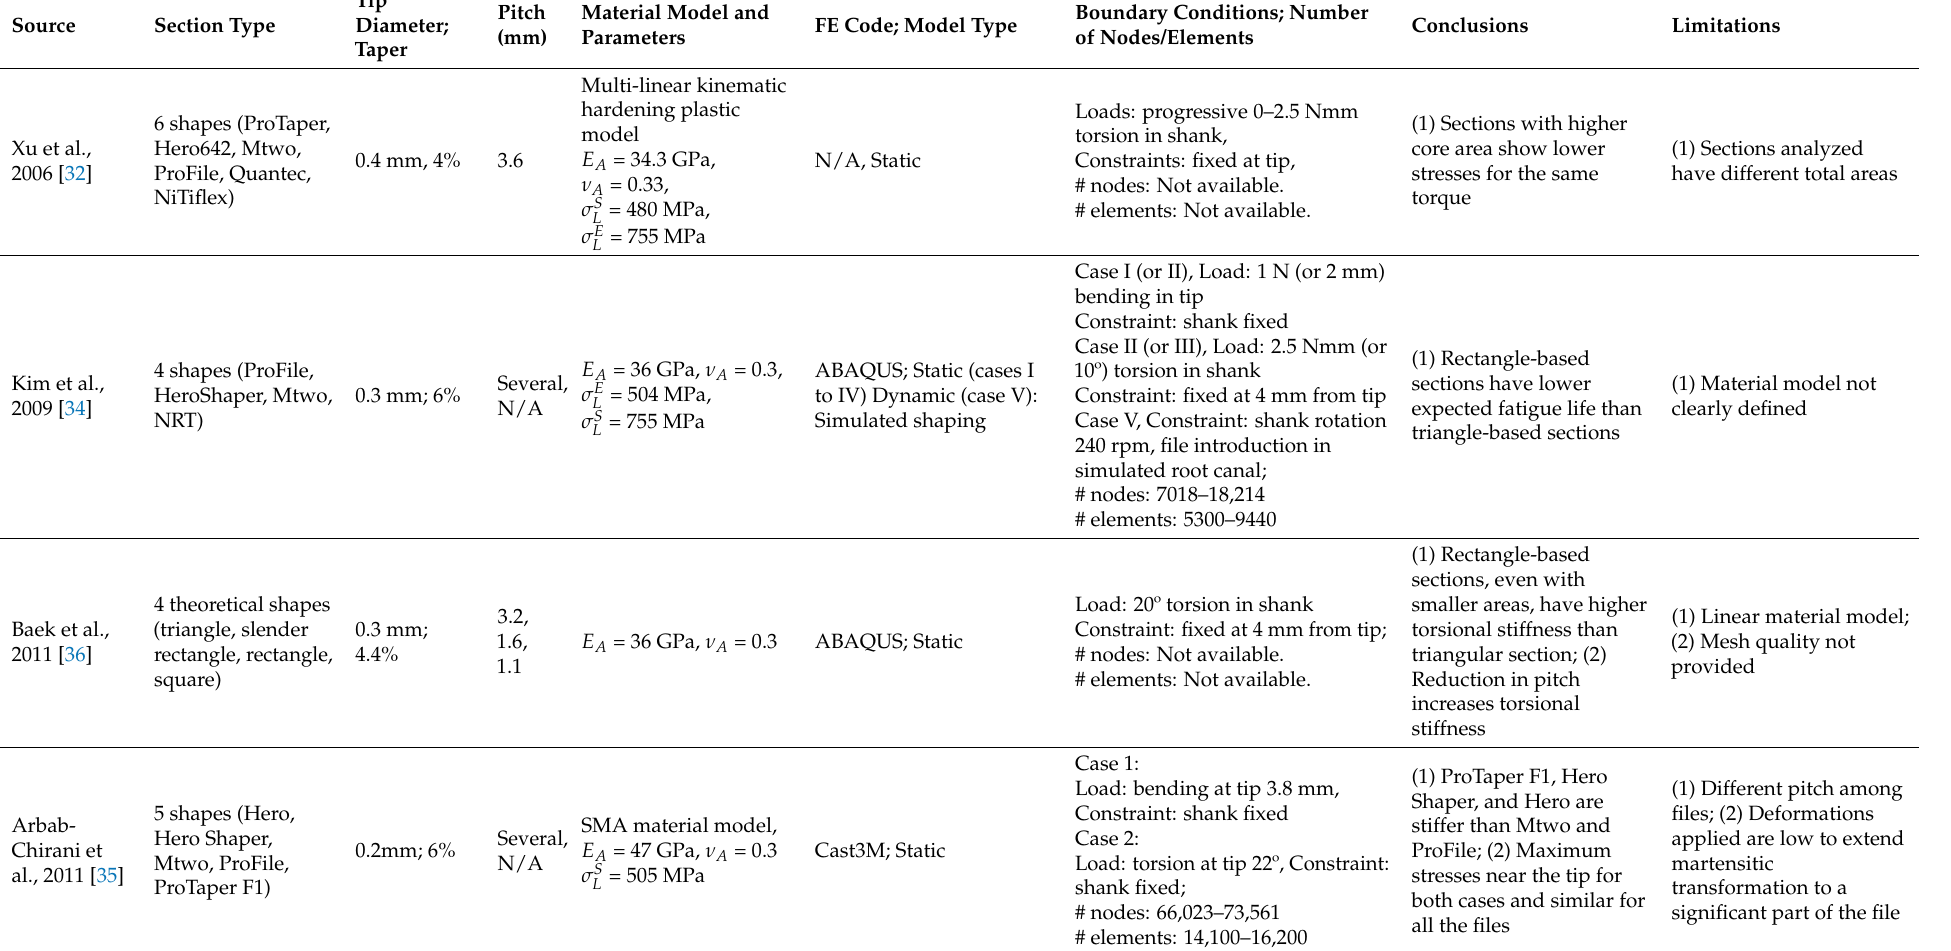
Table A1. Previous FE studies considering the effects of cross-section and pitch on rotary endodontic